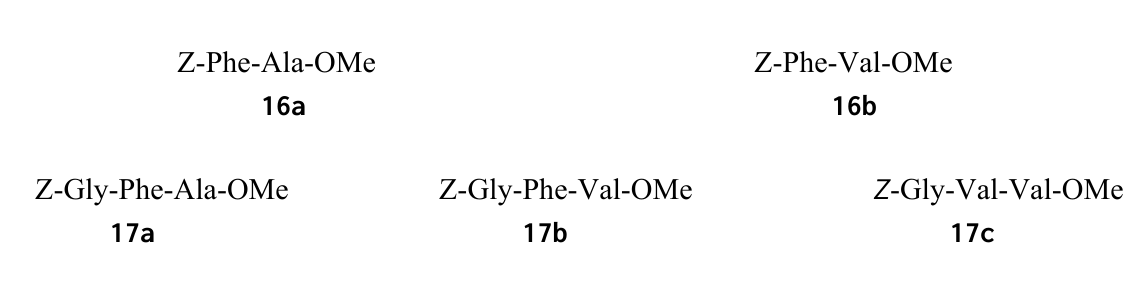
Figure 4. Model of peptide used in racemization